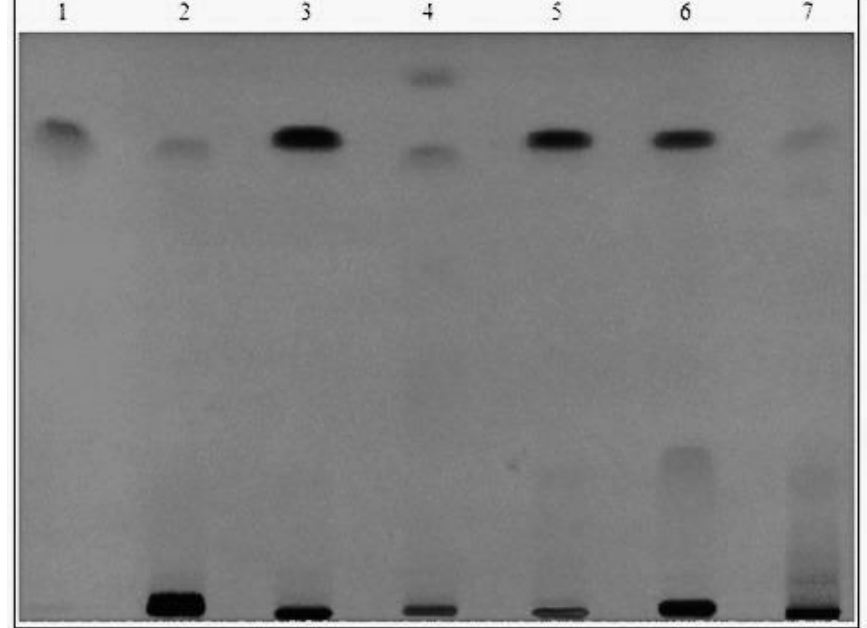
Fig. 2. TLC chromatogram ofanalysed food supplements (1 – reference solution, 2–7 food